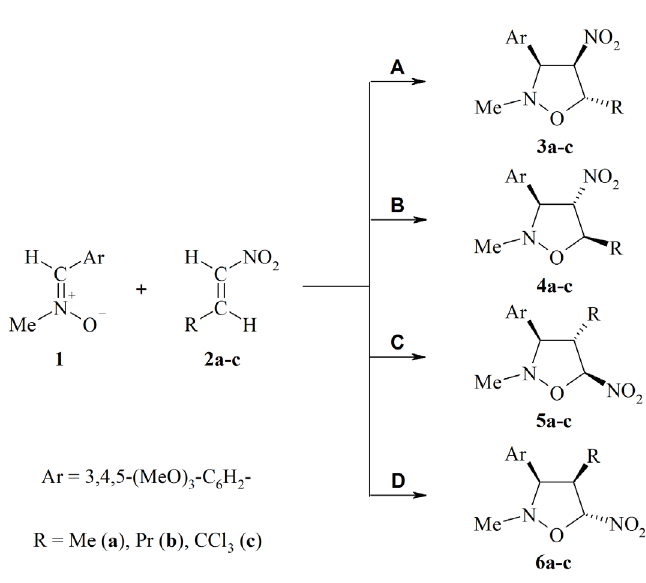
the fractions gave stereoisomeric